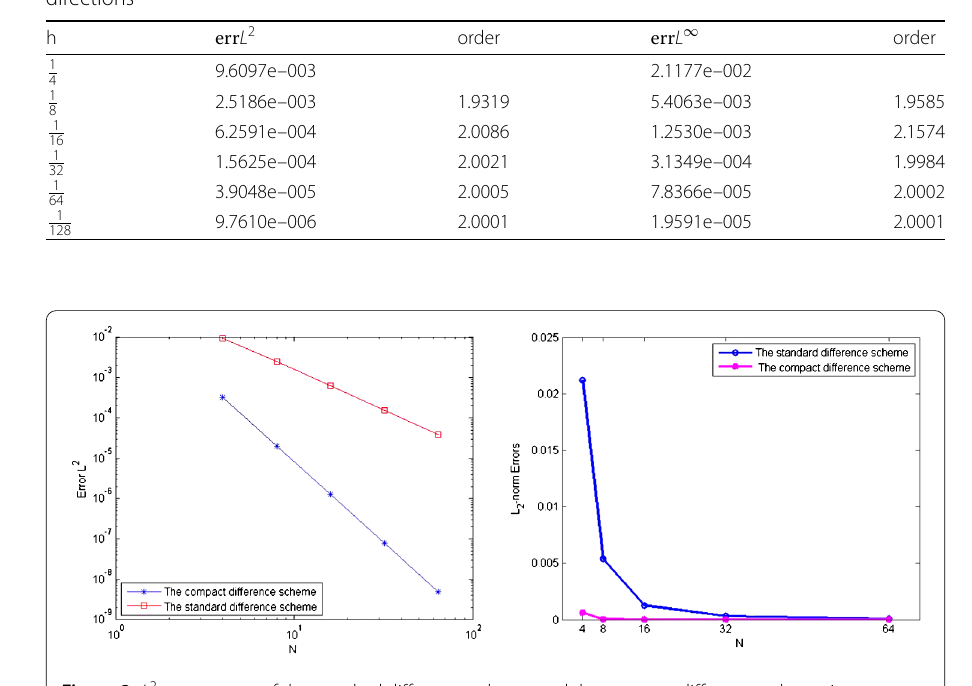
Figure 2 L 2 -norm errors of the standard difference scheme and the compact difference scheme in Example 1. ( a ) Approximation order of C in L 2 -norm. ( b ) L 2 -norm varying with spatial